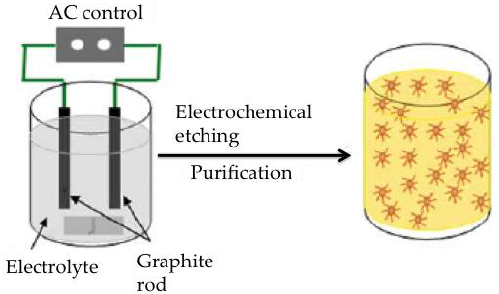
Figure 4. Schematic view of the obtention of CDs by electrochemical methods. Reproduced with permission of [28].